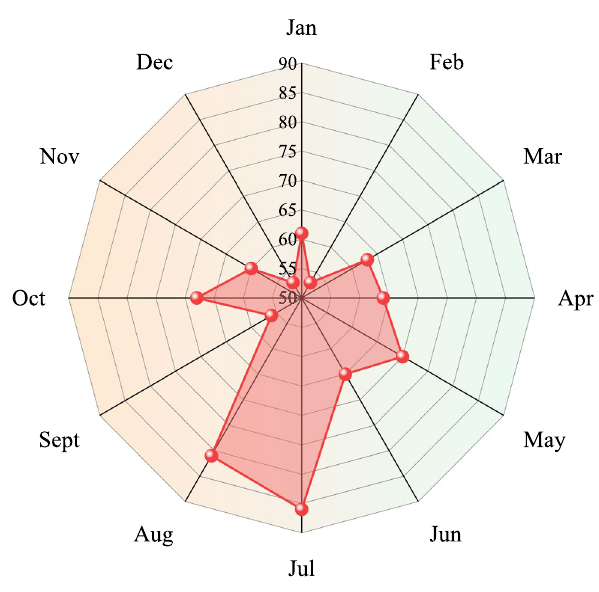
Fig. 10 Number of accidents in different months from 2017 to 2021